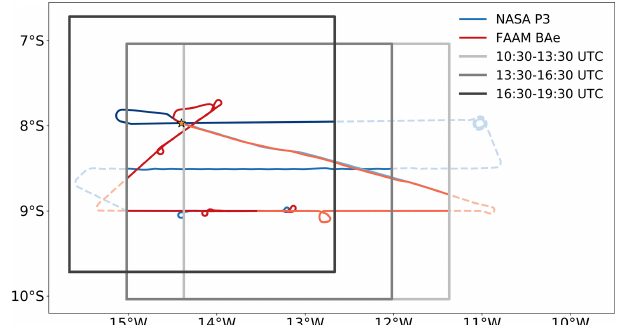
Figure 18. Tracks for the NASA P3 and FAAM BAe aircraft dur- ing the 18 August 2017 joint flight. The regions used for the WRF model averages at each time period are indicated by grey boxes. Flight data occurring at the correct time and location for the first, second, and third time periods are indicated by light, medium, and dark colored solid lines. Dashed lines indicate flight data that do not align with any relevant model data. The location of Ascension Island is marked by the yellow